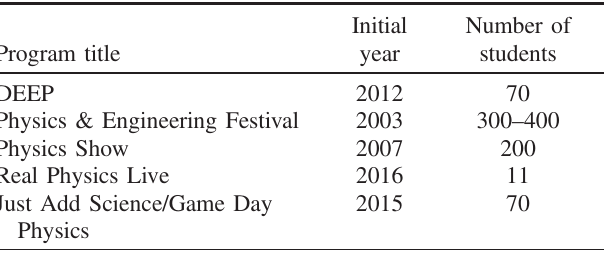
TABLE I. Approximate number of annual student participants and the inaugural year for the Texas A&M informal physics programs included in this study.